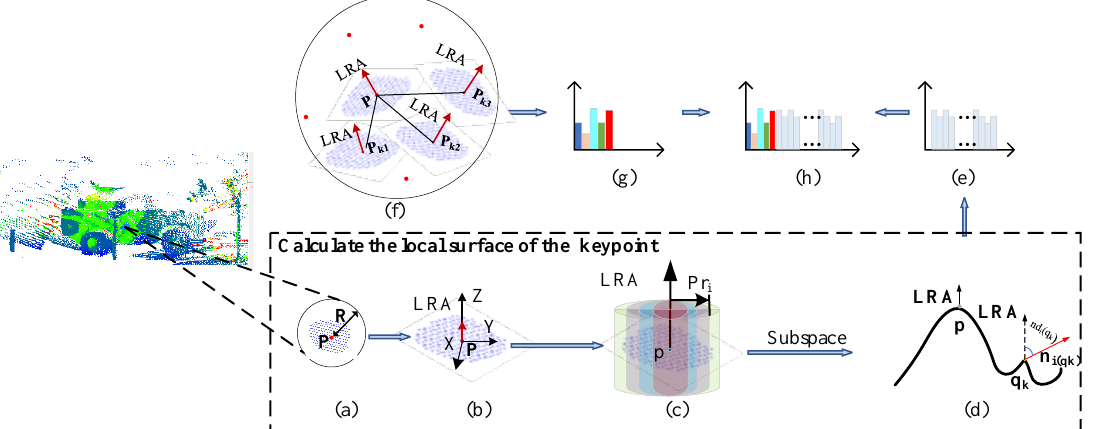
Figure 2. Graphic representation of the descriptor ( a ) extract the local surface around the feature point p on the model. ( b ) Construct the LRA of the p point and align it with the z axis of the local surface. ( c ) Divide the local space along the LRA axis and projection radial. ( d ) Calculate the deviation between the LRA and the normal in the subdivision space. ( e ) Generate the histogram of the local surface. ( f ) Statistical feature point p and three nearest neighbor keypoints. ( g ) Generate sub- histograms of feature point information. ( h ) Connect all sub-histograms, generate DASKL descriptor. In each partition, the geometric information is encoded using the statistics of the deviation angle between the feature point LRA and the normal of the adjacent points. The deviation angle between the normal and the LRA is calculated as